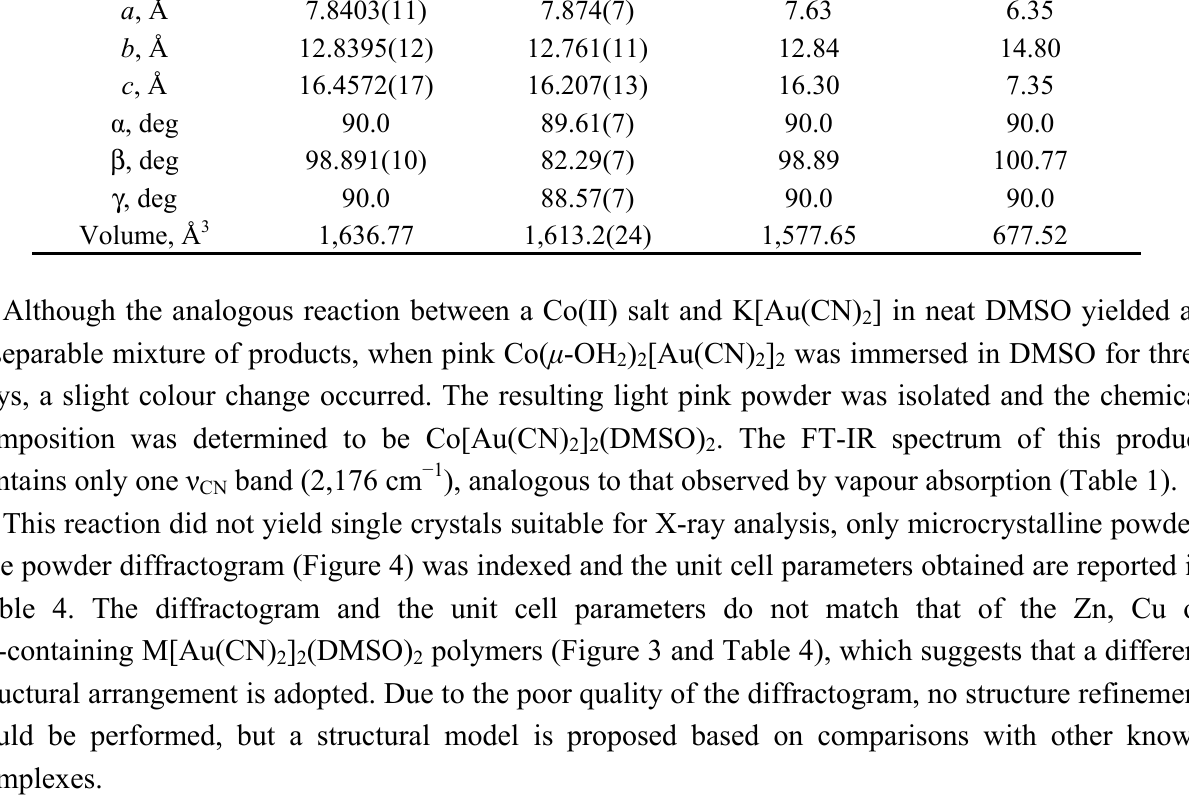
] (DMSO) coordination 2 2 2